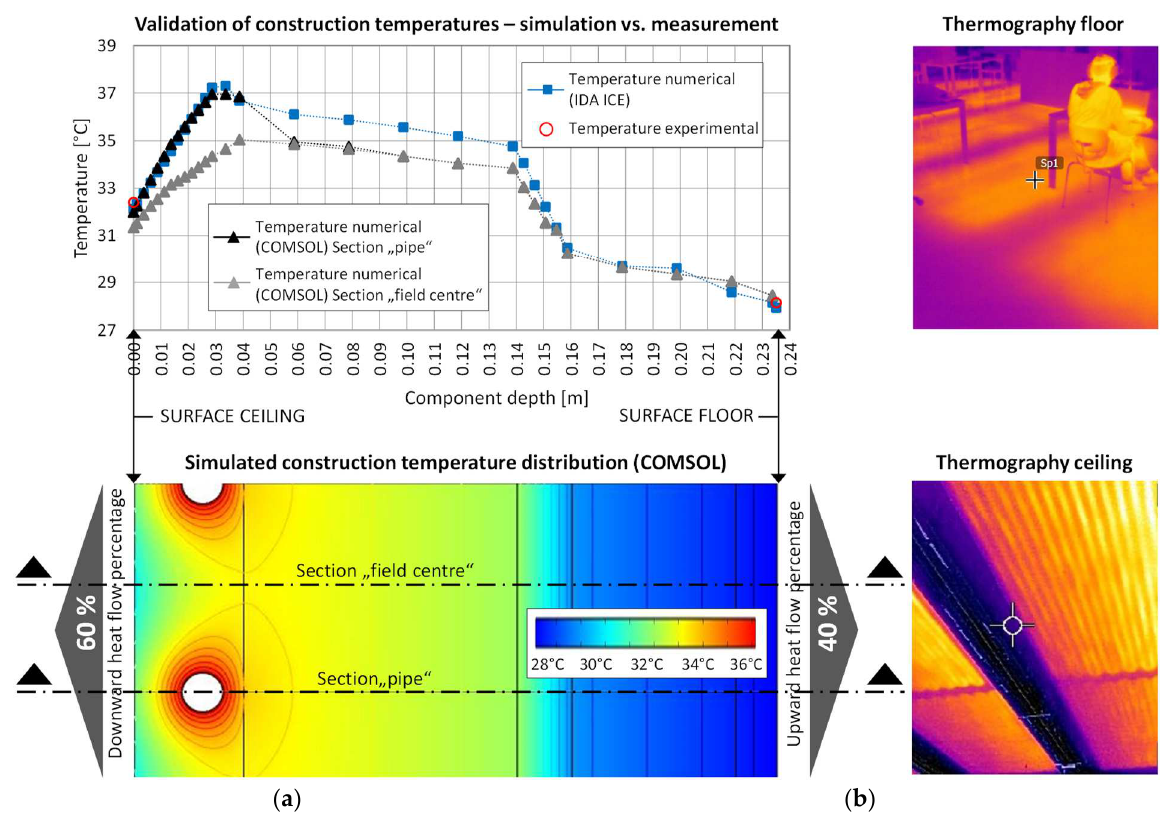
Figure 5. Temperature curve in the ceiling component during heating operation of the plastered heating meander ( a ) and thermography of the ceiling ( b ).